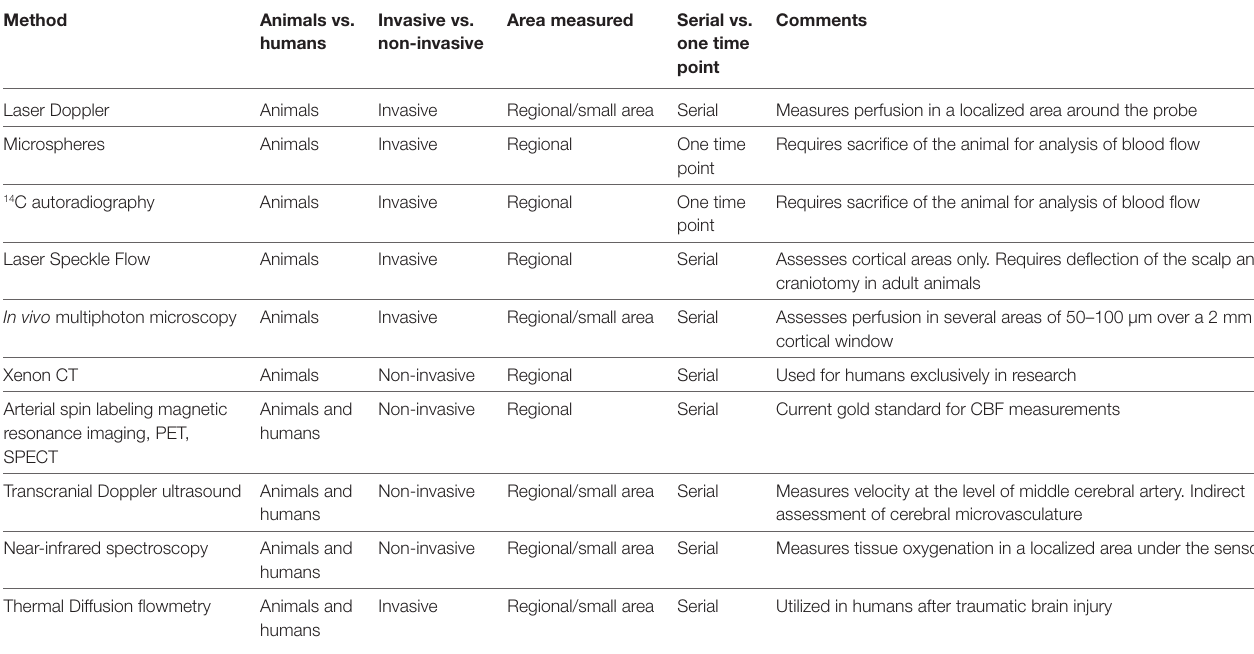
TABle 1 | Current methods for assessment of cerebral blood flow (CBF) in animals and